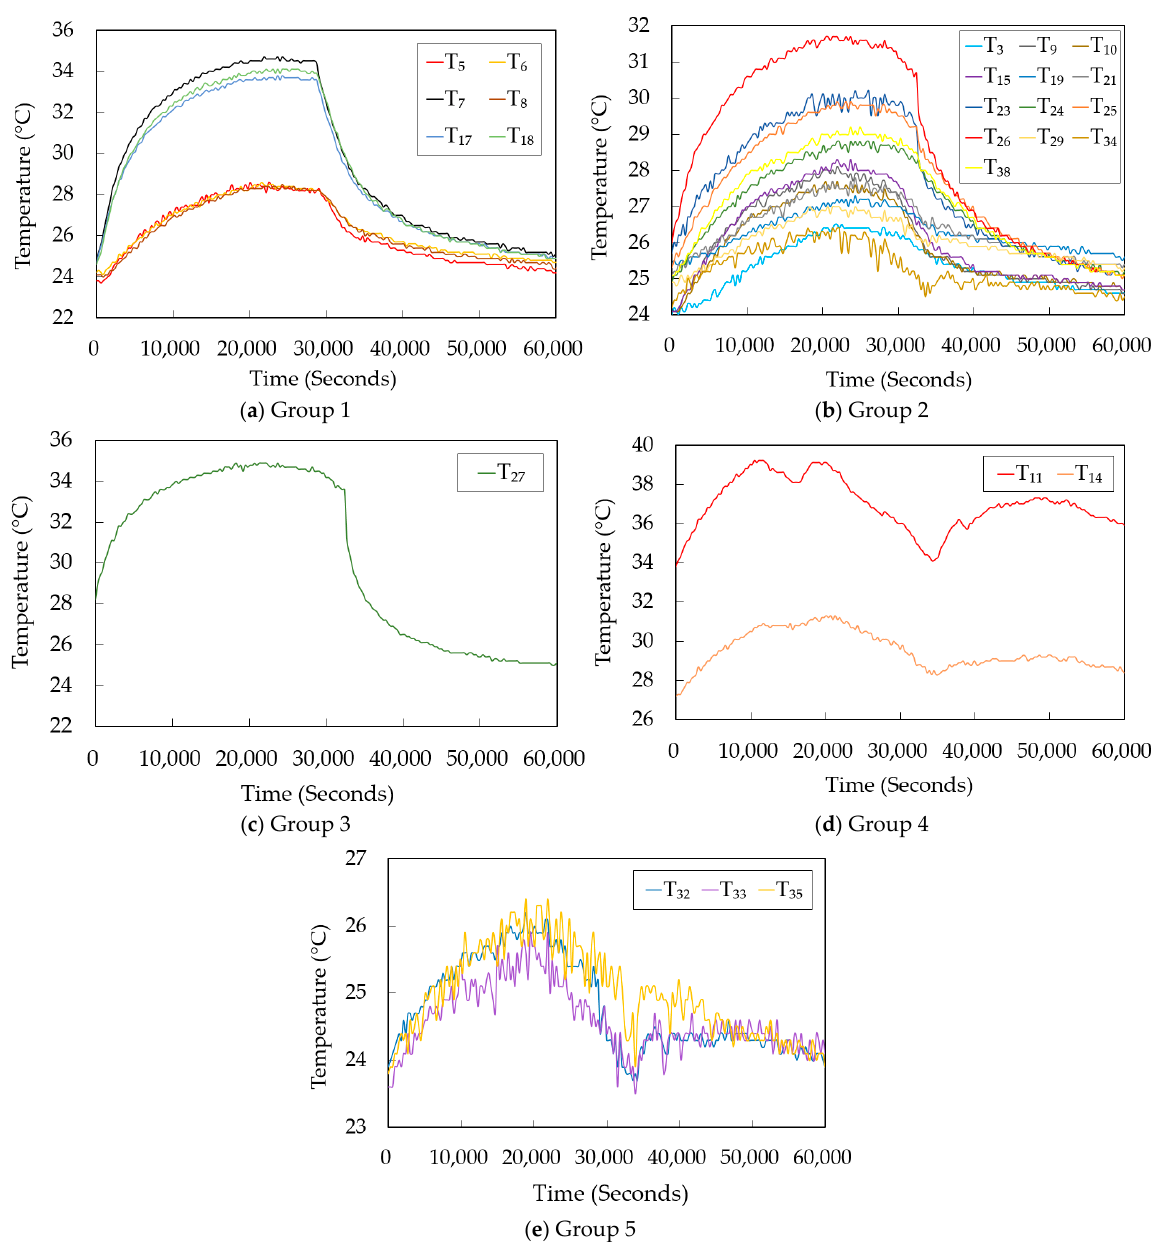
Figure 7. Temperature trends within the first five groups.